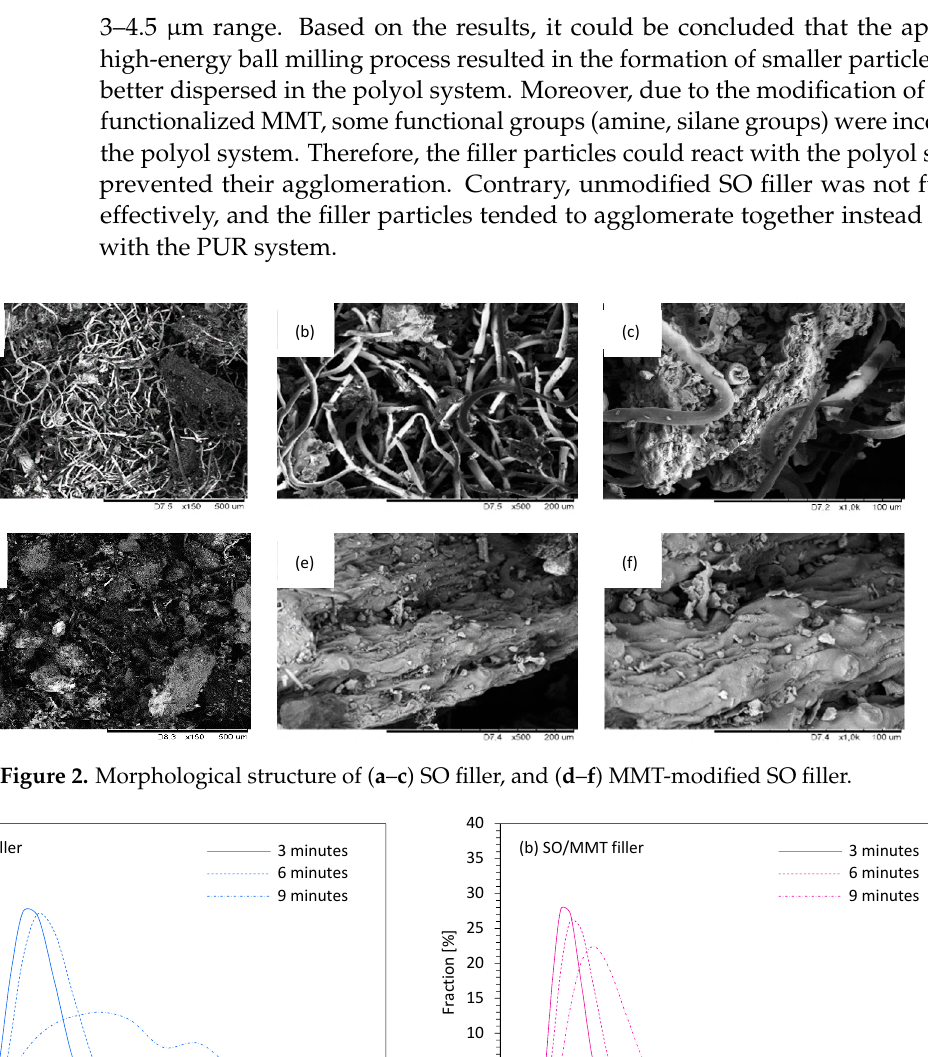
Figure 2. Morphological structure of ( a – c ) SO filler, and ( d – f ) MMT-modified SO filler.